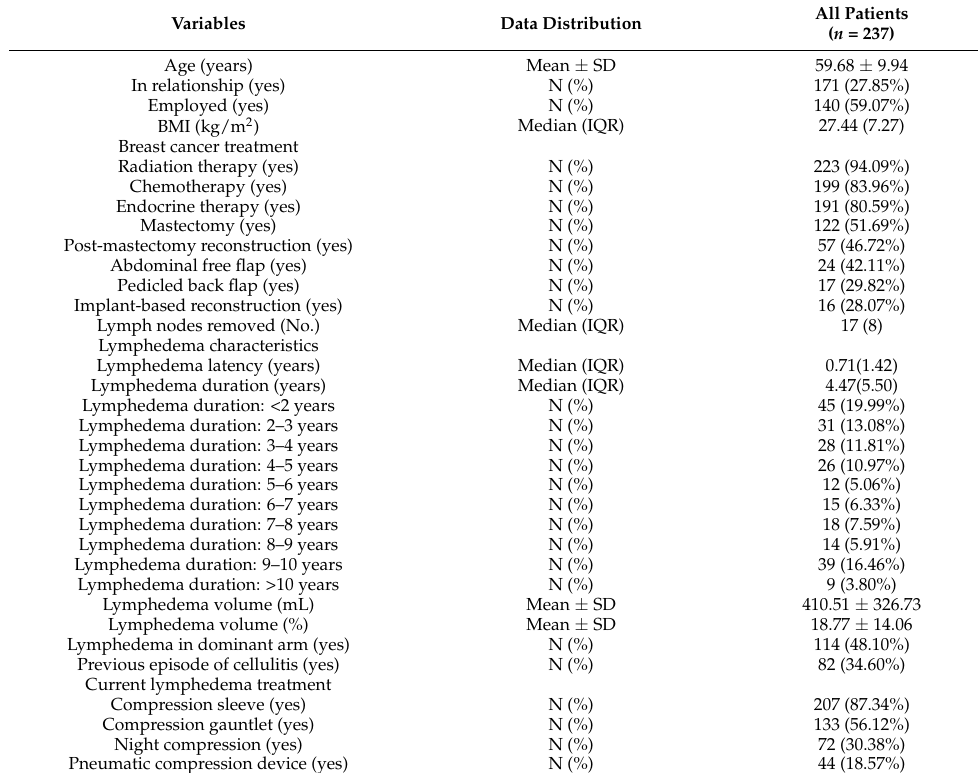
Table 2. This table shows the patient demographics of the included patients. SD = standard deviation, N = number. IQR = interquartile range.